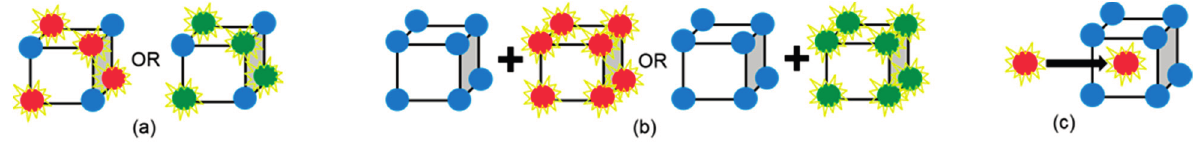
Figure 2. Schematic representations of the expected combined MOF structures: ( a ) mixed Ln based-MOFs; ( b ) mixture of two different pure Ln based-MOF; ( c ) Nd based-MOF including a second Ln element (Nd, blue; Eu, red; Tb, green; yellow circumference represents